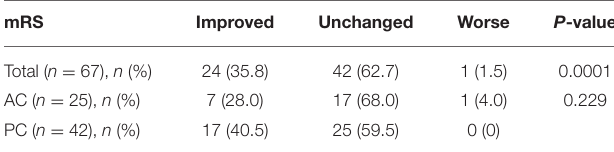
TABLE 5 | Clinical status of included